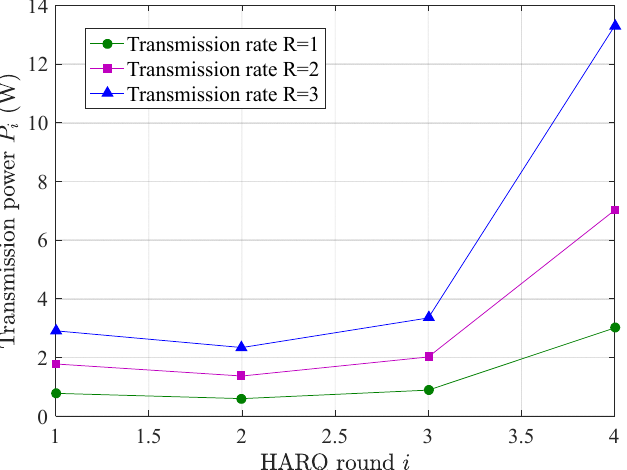
Figure 8. The value of P i ( 1 ≤ i ≤ L ) to be used in different IR-HARQ rounds for the IR-HARQ-VPA scheme ( K = 2, (cid:101) 0 = 10 − 3 , L = 4 ) .